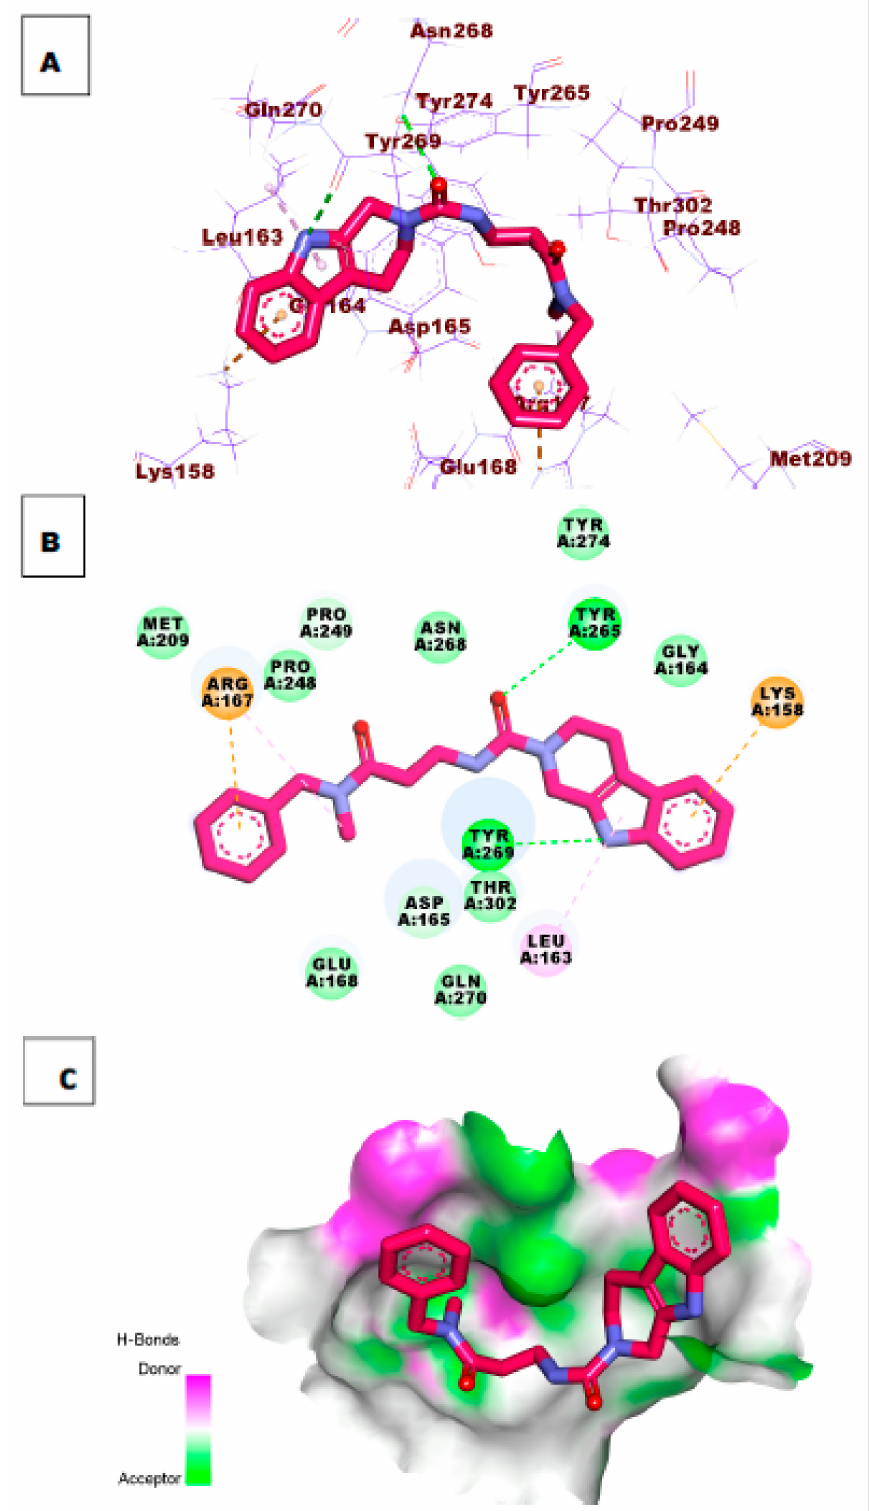
Figure 9. ( A ) 3D of compound 54 docked into the active site of PLpro. ( B ) 2D of compound 54 docked into the active site of PLpro. ( C ) Surface mapping of compound 54 docked into the active site of